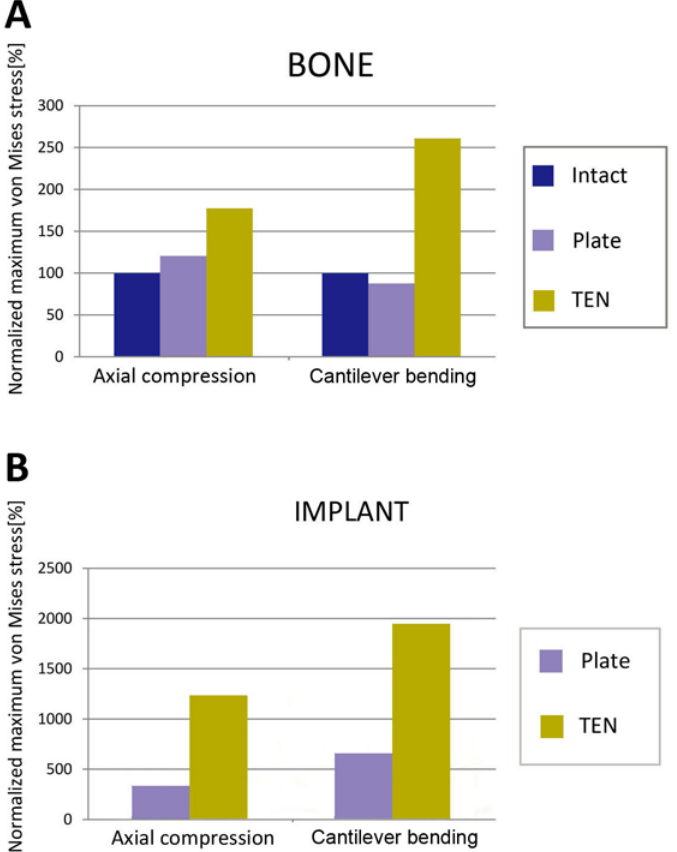
Fig 7. Peak von Mises stresses normalized to the stresses measured in the intact clavicle during the corresponding loading conditions for the bone (A) and the implant